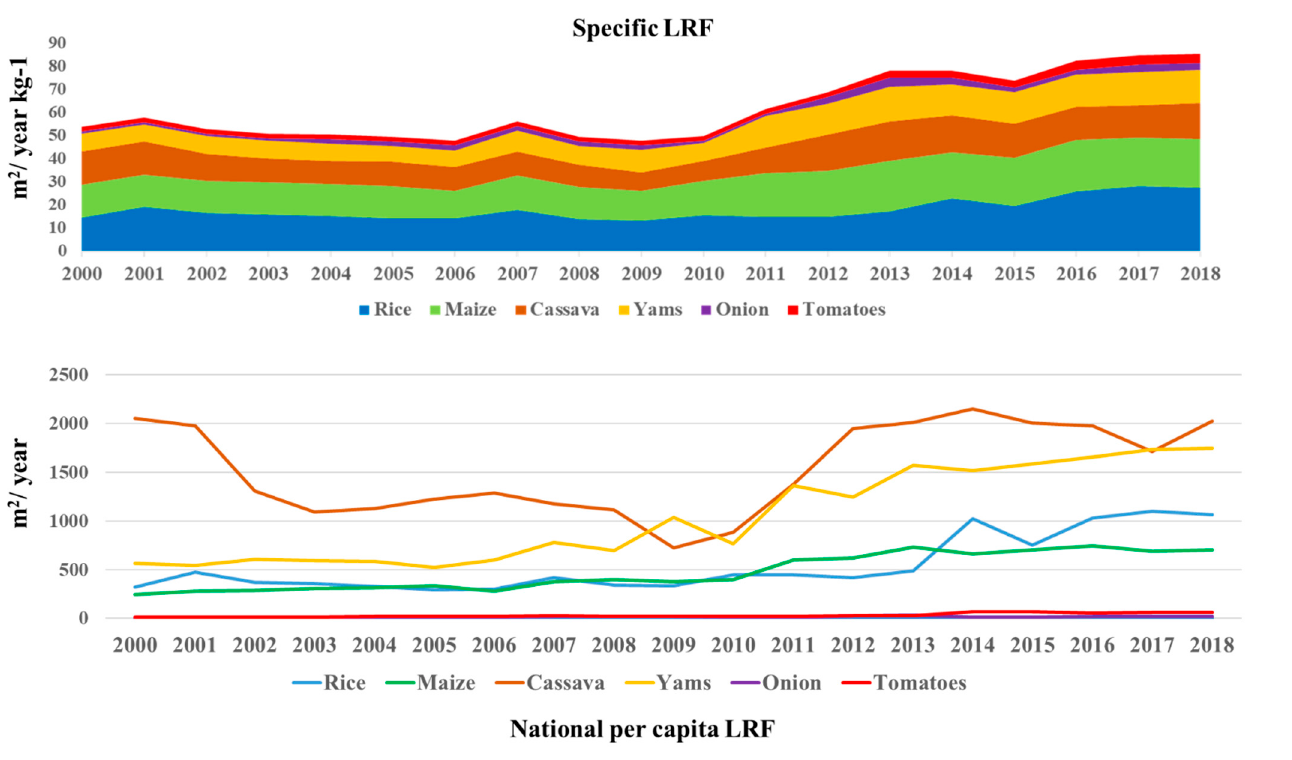
Figure 6. National specific and per capita land requirements for food in Nigeria (data source: FAOSTAT). Table 5. Current gap in household land requirements for food in Nigeria and in the six geopolitical